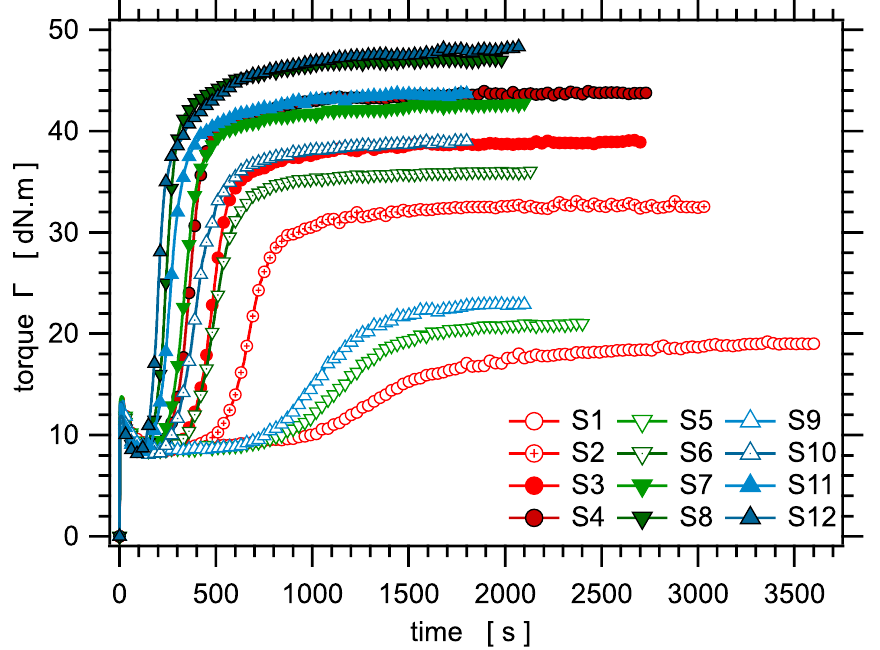
Figure 1. The rheological torque measured during curing for the series of crosslinked